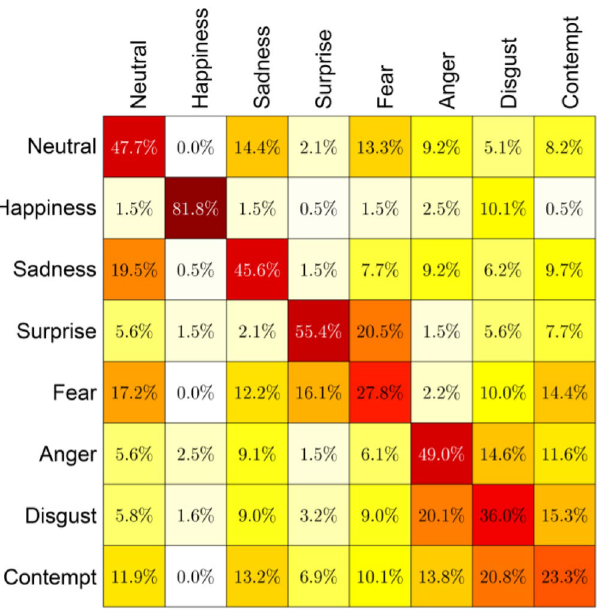
Figure 14. Confusion matrix of the compared method presented by Kopaczka et al. 12 .